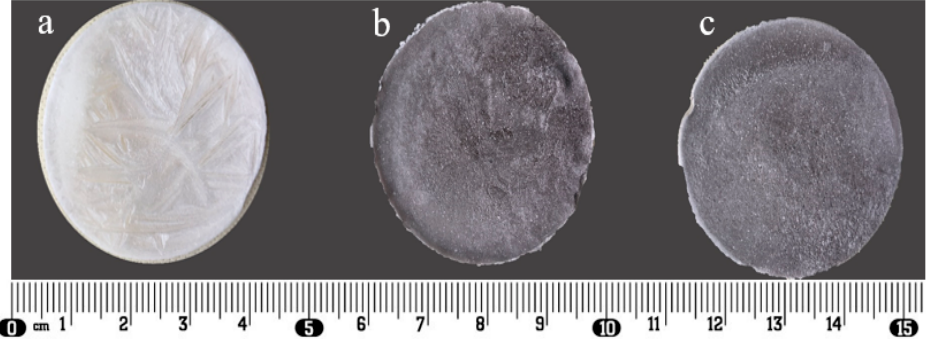
Figure 2. The images of ( a ) KPPA0; ( b ) KPPA2 and ( c ) KPPA4 cryogels.